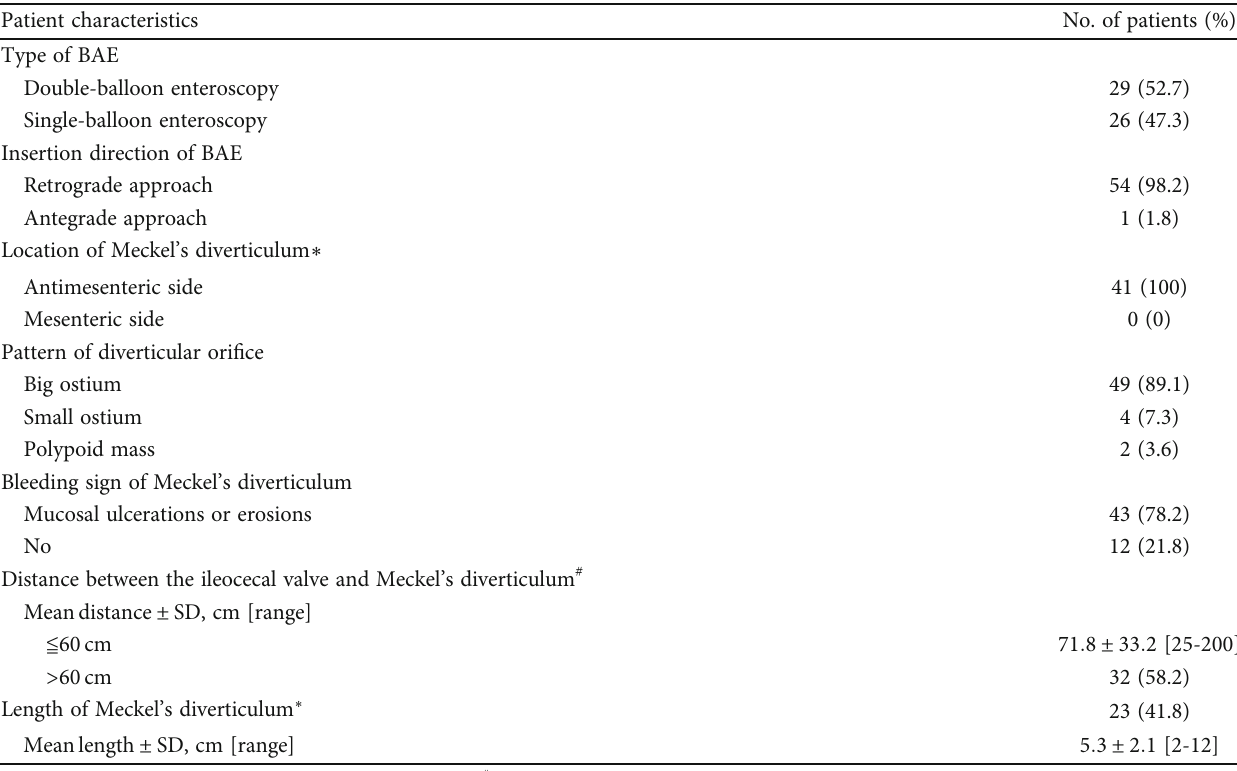
Table 2: The diagnostic modalities and methods, endoscopic features, and anatomic appearances of patients with Meckel ’ s diverticulum diagnosed by BAE ( n = 55 ).